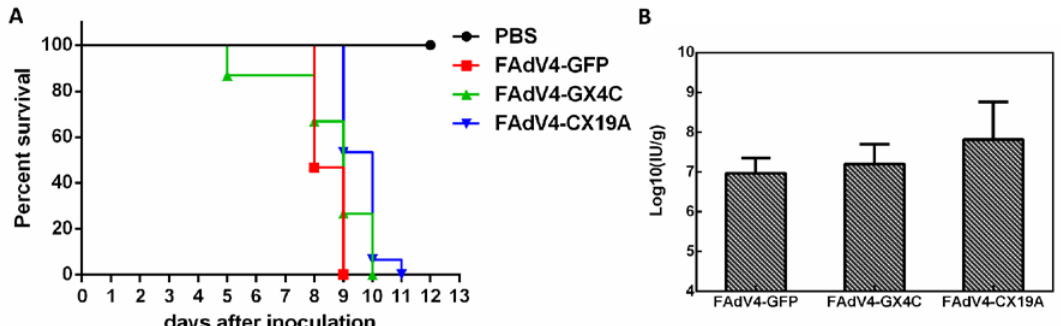
Figure 8. Inoculation of embryonated chicken eggs with recombinant FAdV-4. Sixty six-day old embryonated chicken eggs were randomly divided into four groups (15 eggs per group), and three groups were inoculated with FAdV4-GFP, FAdV4-GX4C or FAdV4-CX19A of 2 × 10 8 vp in 100 µ LPBS via yolk sac route, respectively. The PBS group was injected with 100 µ LPBS containing no virus, and served as uninfected control. The viability of embryos was checked every 24 h. Livers from dead embryos were weighed and collected for virus titration. ( A ) Survival curve of embryonated chicken eggs after viral inoculation. ( B ) Virus amount in liver normalized by liver weight, which was shown as infectious units per gram of liver (IU/g).